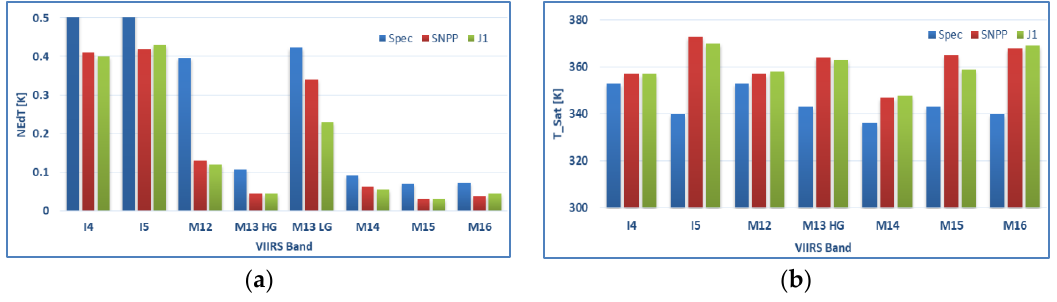
Figure 8. S-NPP and JPSS-1 VIIRS TEB ( a ) noise equivalent temperature difference (NEdT) and ( b ) saturation temperature.